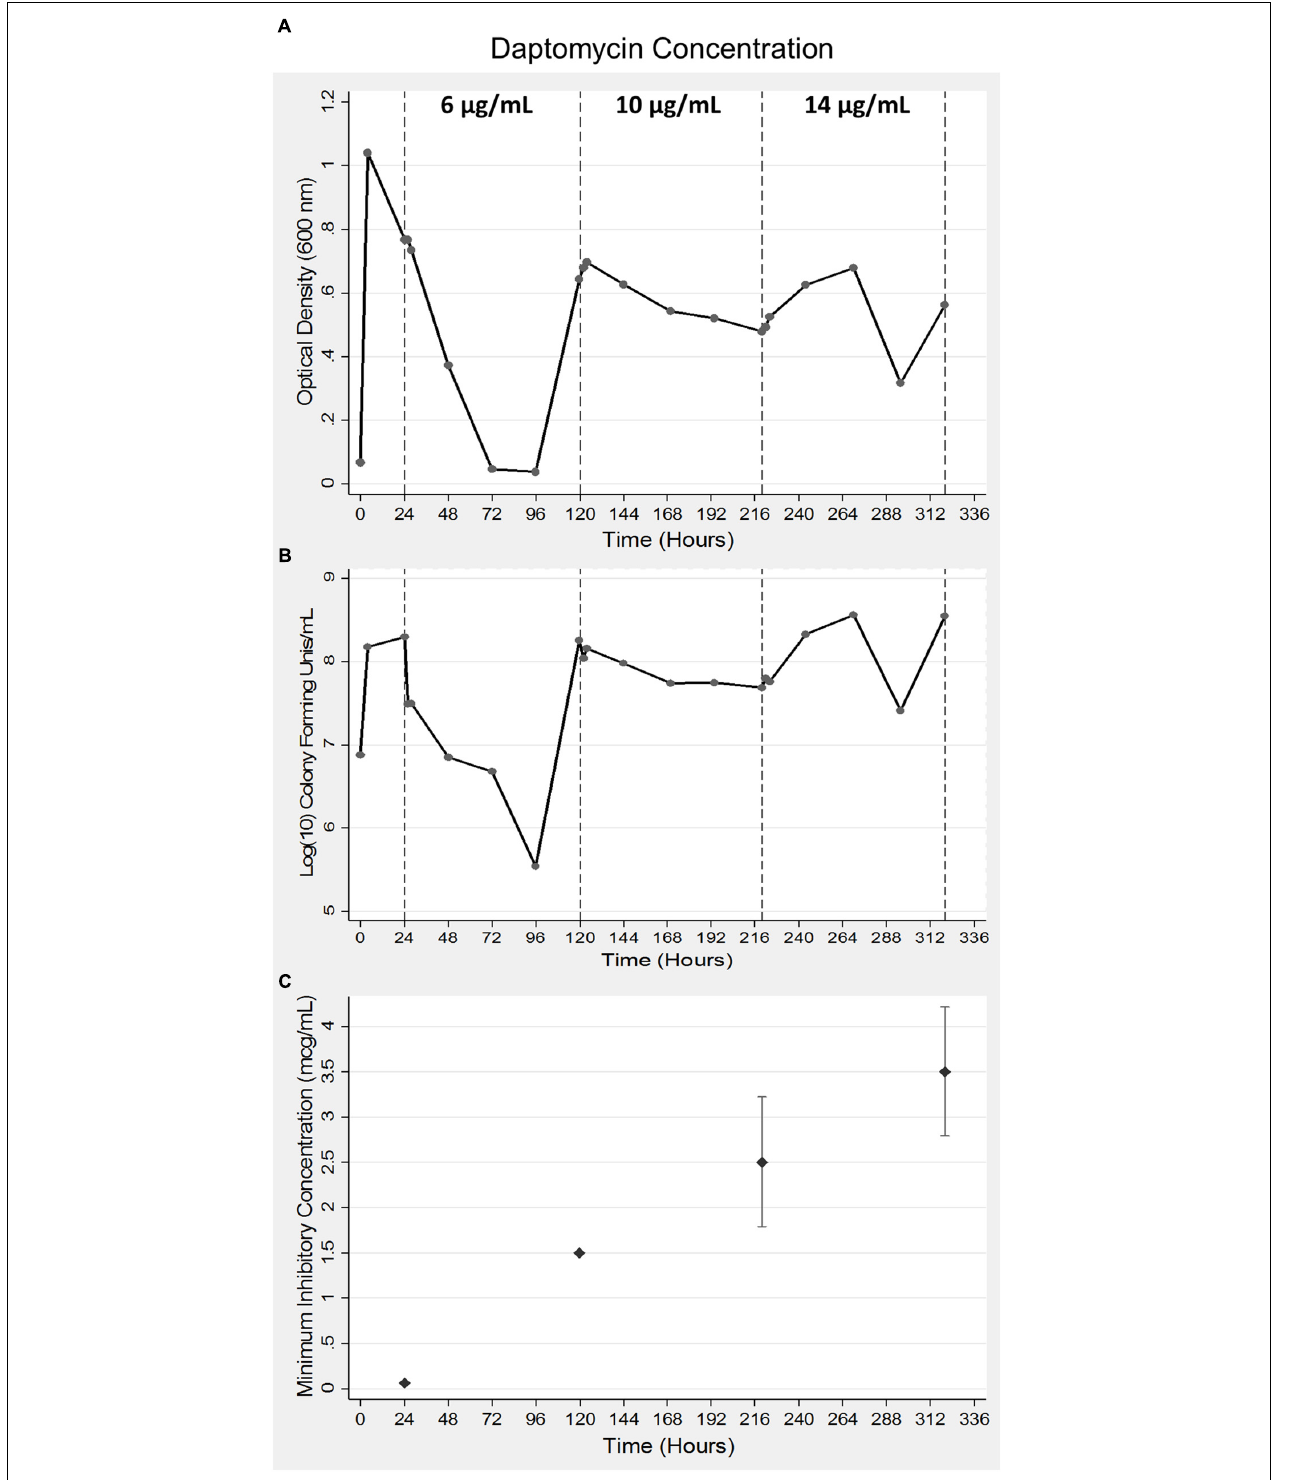
FIGURE 1 | Acquisition of daptomycin resistance in S. aureus using a bioreactor model. Bacteria were grown for a period of 24 h after which daptomycin was added at indicated concentrations at 24, 120, and 220 h of growth in a bioreactor. Samples were collected at 24 h intervals to measure optical density at 600 nm (A) and bacterial viability was determined by counting CFUs (B) . The data shown are representative of three independent experiments conducted (A–C) . The MICs of the bacterial aliquots collected at the indicated times were determined as described in the Methods section (C) . The data are presented as mean ± SD and are representative of three independent experiments conducted with two replicates